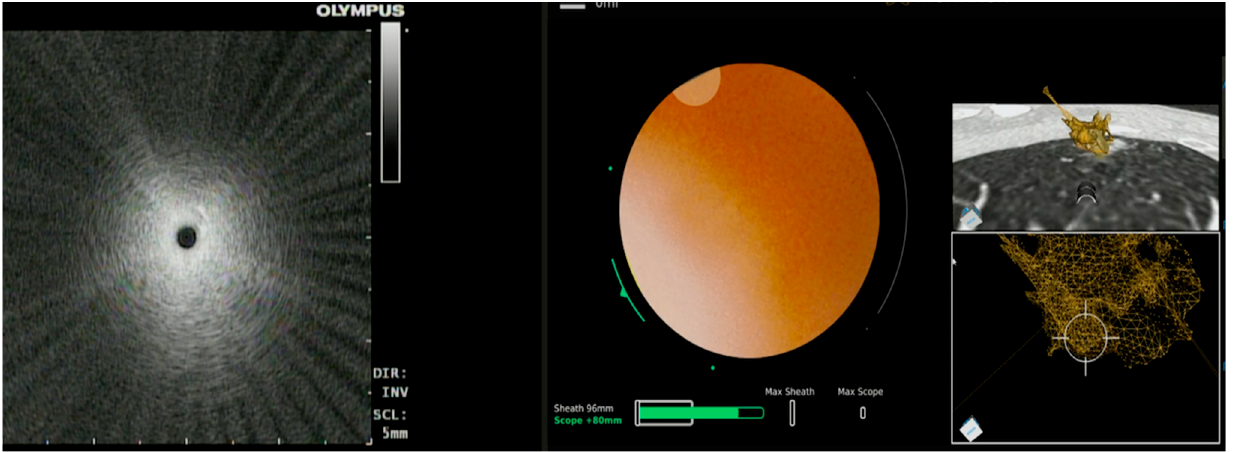
Figure 2. Navigation software feedback showing alignment of the bronchoscope in line with the nodule, but no ultrasound image obtained with radial EBUS.